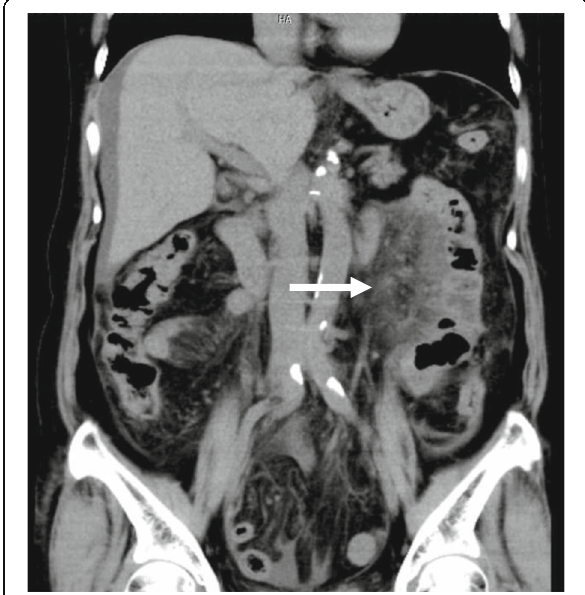
Fig. 1 CT image on admission. The thickening mesentery adjacent to the jejunum is showed (arrow). A periarterial halo or stenosis in the superior mesenteric artery is not remarkably